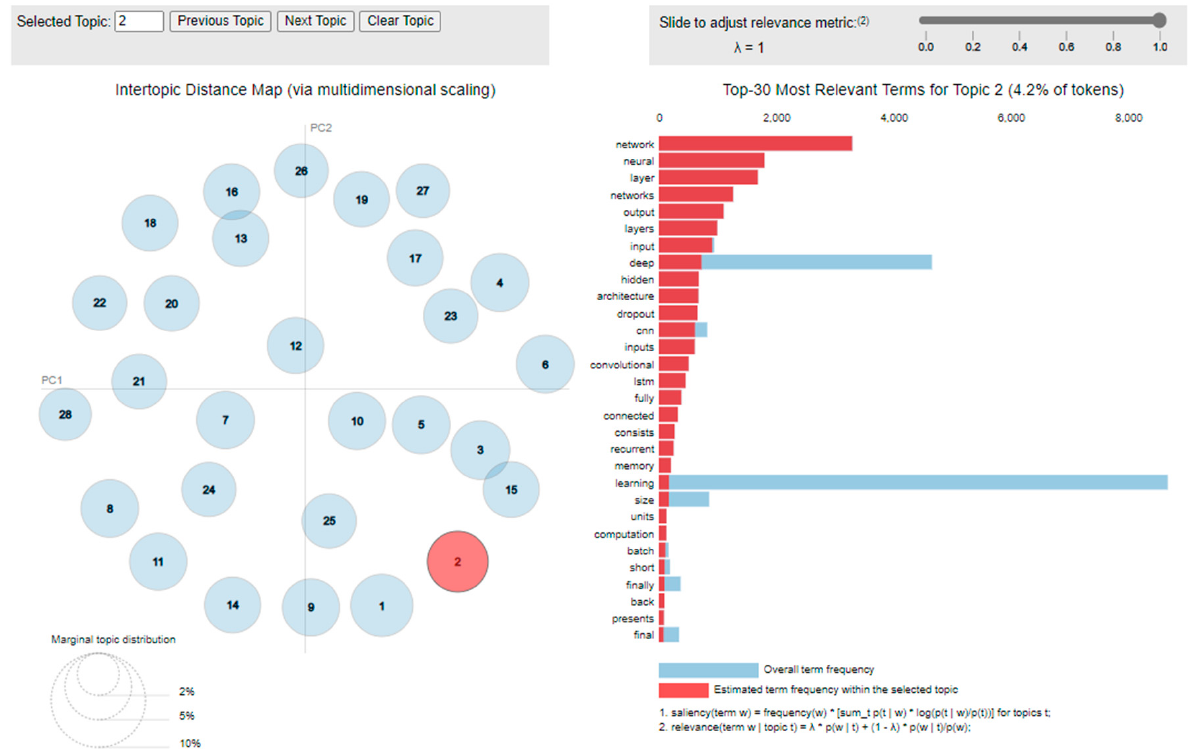
Figure 2. Visualization of a bag of words on the subject of recurrent and convolutional neural networks.